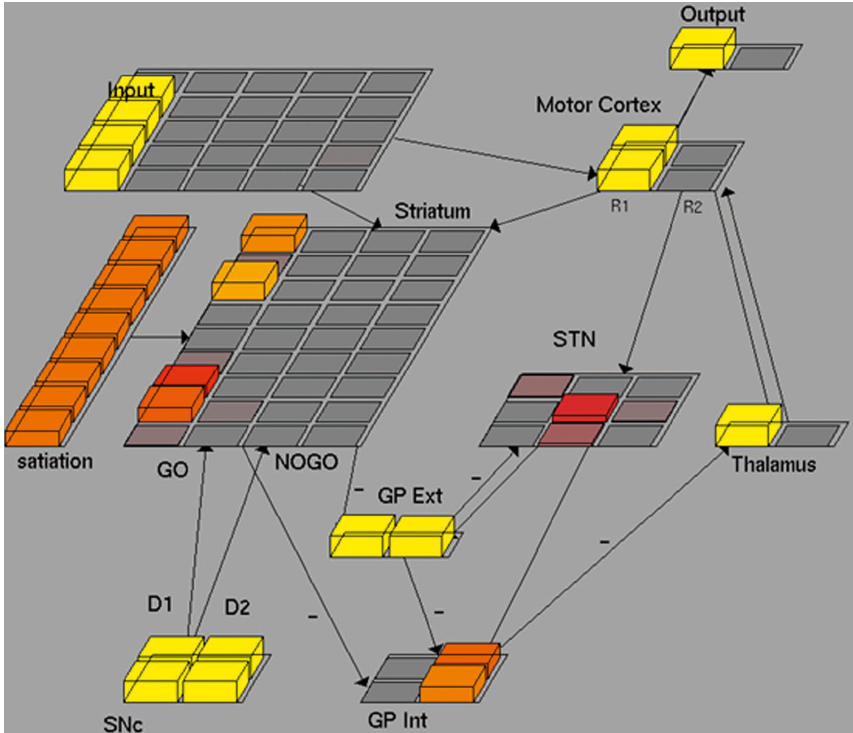
Figure 2. Neurocomputational model showing the satiation layer and connection between satiation layer and